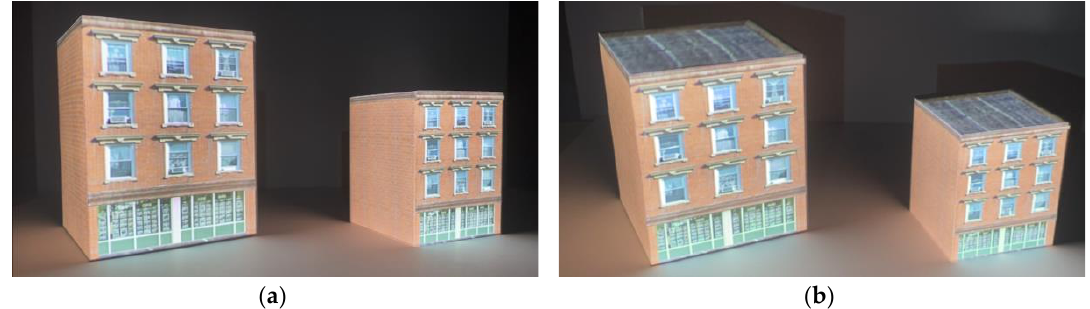
Figure 4. Comparison of projection results in two model sizes, ( a, b ) images shot from different angles.